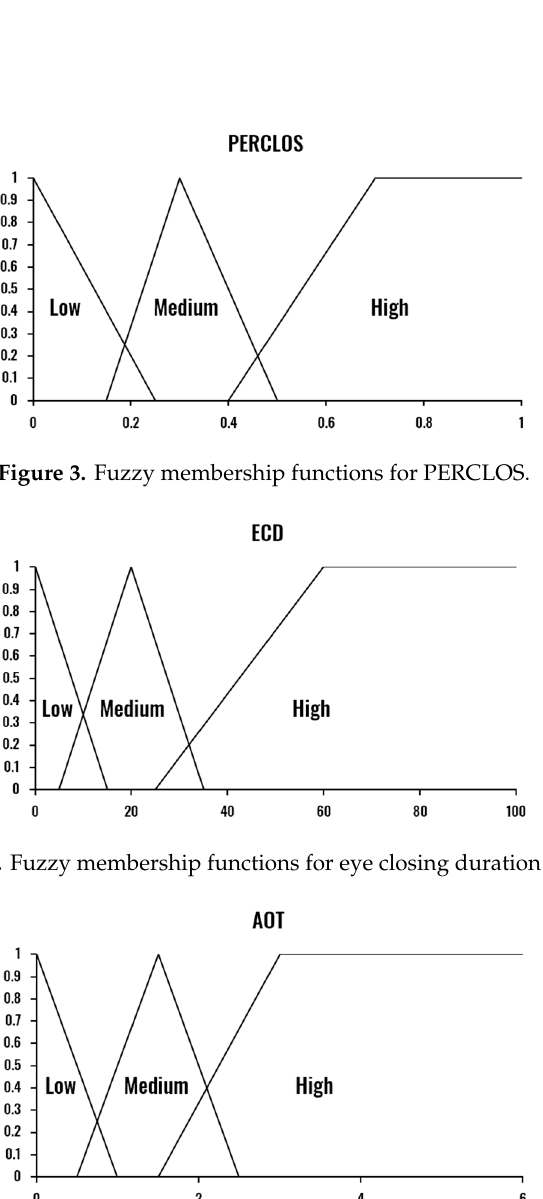
Figure 7. Fuzzy rules (L = Low, M = Medium, H = High). 2.5. Hardware The main hardware component is the Raspberry Pi 3 Model B [43], which possesses a Quad Core 1.2 GHz Broadcom BCM2837 64 bit processor combined with a memory of 1 GB. The device operates as a minicomputer that executes the operating system Raspbian [44] (an operating system based on